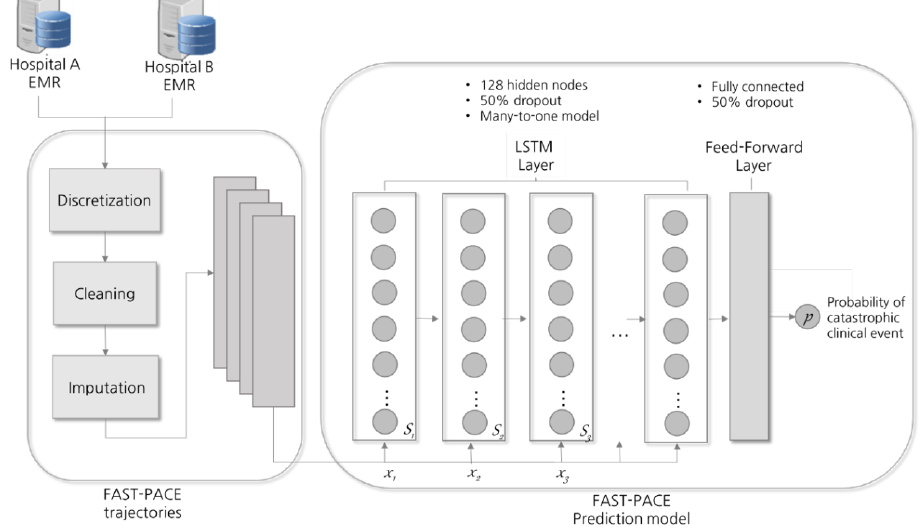
Figure 3. Prediction model design. LSTM = long short-term memory; x = input; S = memory cell.